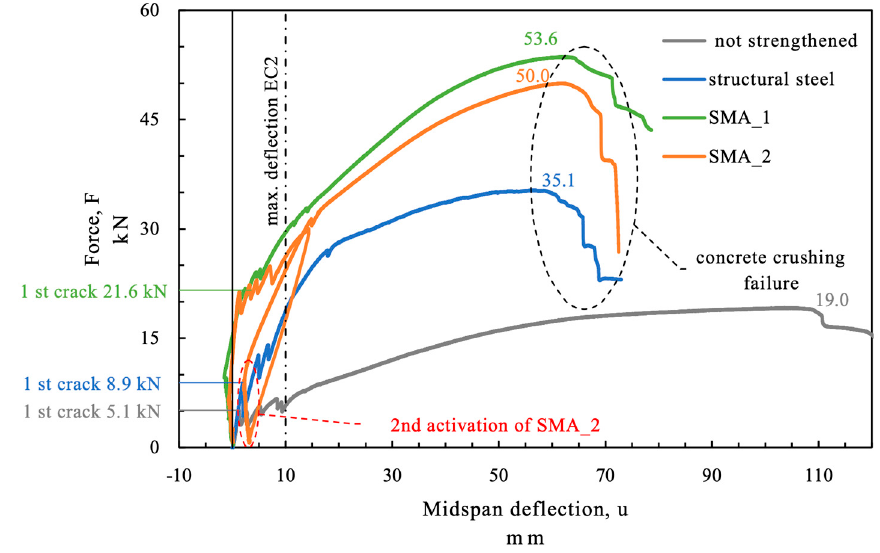
Figure 11. Load displacement behavior of the (strengthened) RC beams in the test.